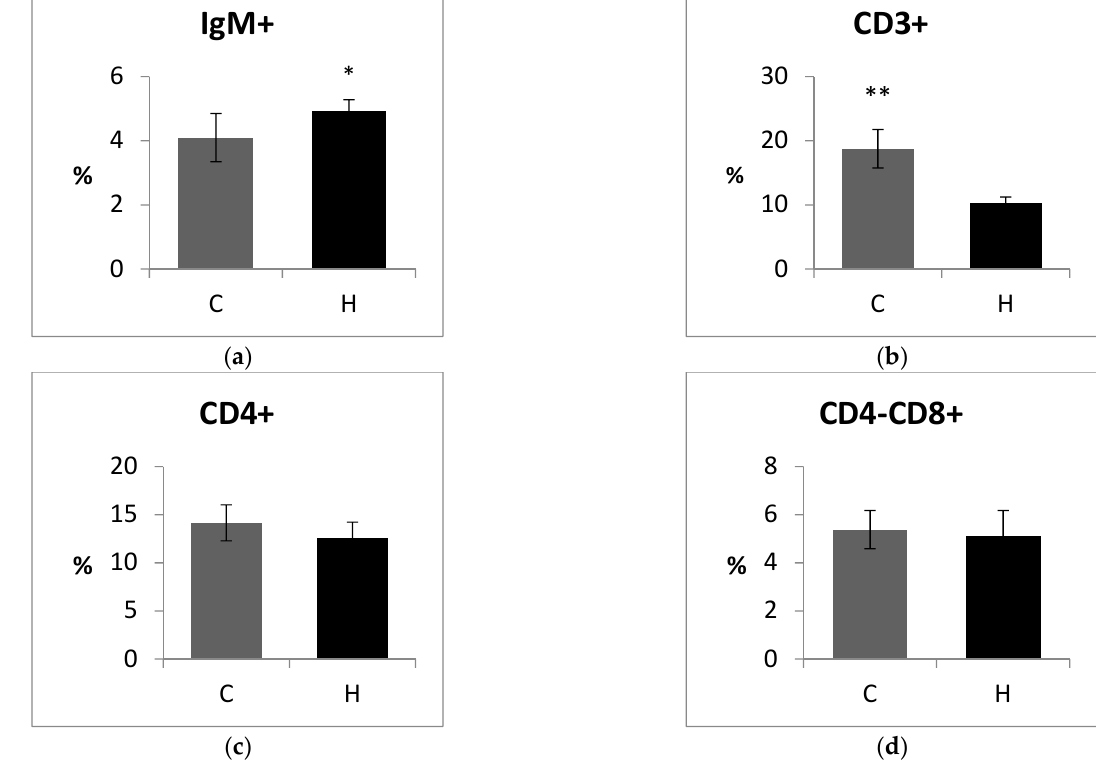
Figure 3. Percentage of ( a ) IgM+, ( b ) CD3+, ( c ) CD4+, and ( d ) CD4-CD8+ lymphocytes in the blood of laying hens receiving 0.5% HS. C: control group; H: layers fed a diet enriched with supplementation of 0.5% HS. Columns marked with stars are significantly different from control: * p < 0.05; ** p < 0.01.